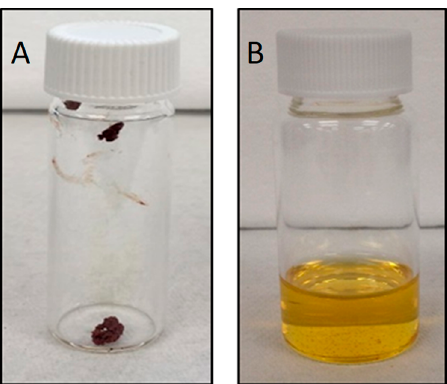
Figure A5. ( A ). Selenocyanate Propionic Ester of N -hydroxysuccinimide (Bolton-Hunter Reagent). ( B ). Unsaturated Solution of Se-Ester dissolved in Tetrahydrofuran at a concentration of 20 mg/mL.